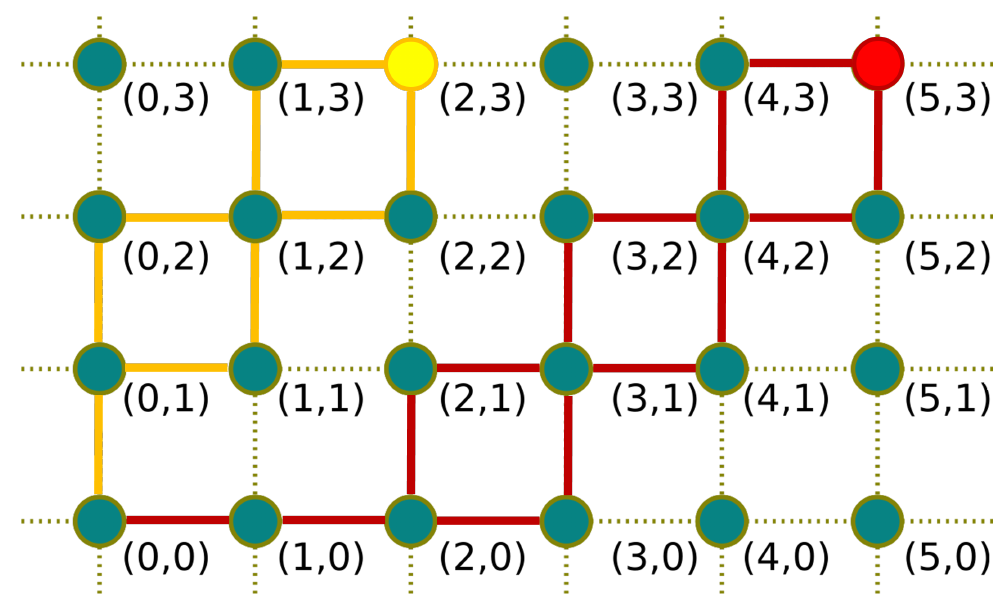
Figure 3. Minimum-hop paths between edge